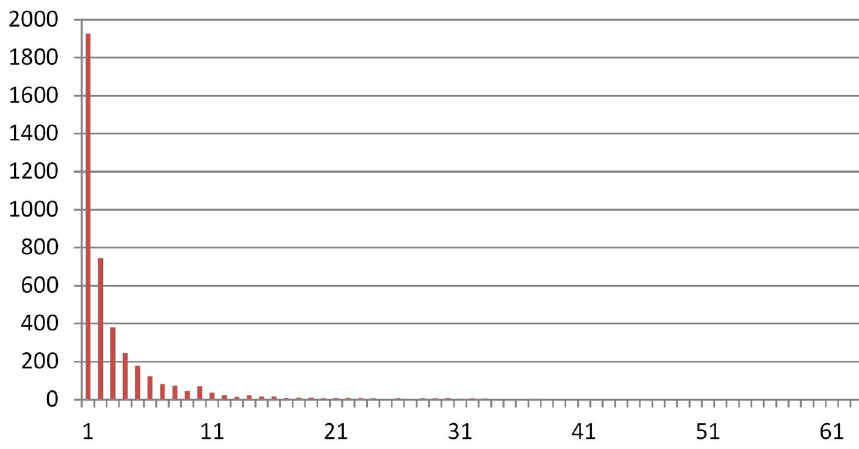
Figure 1. Distribution of associated document amounts of each GO term.